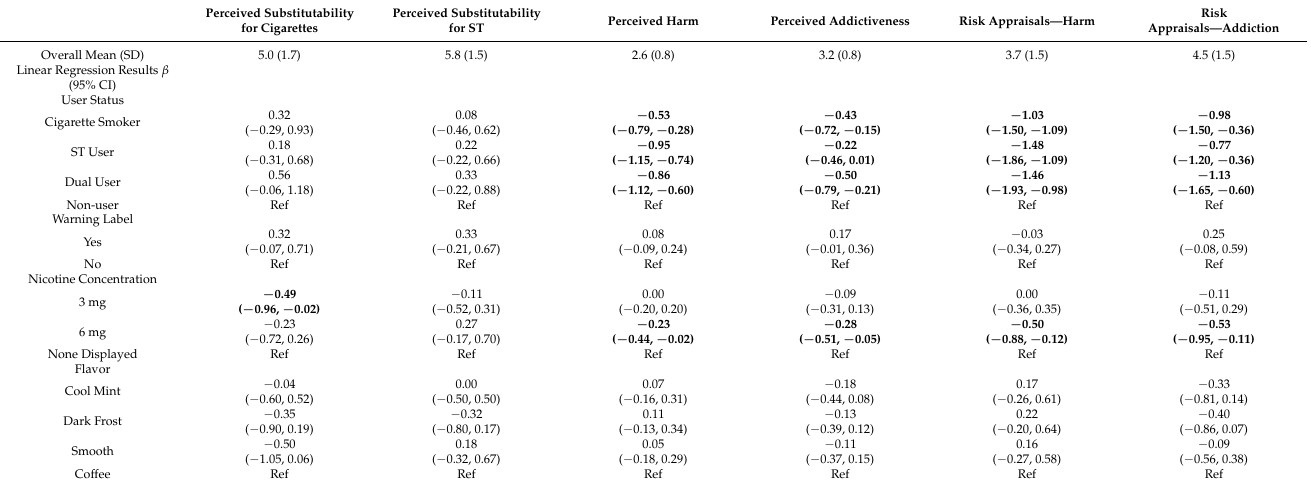
Table 2. Overall Means for Perceptions of Oral Nicotine Pouches and Linear Regression